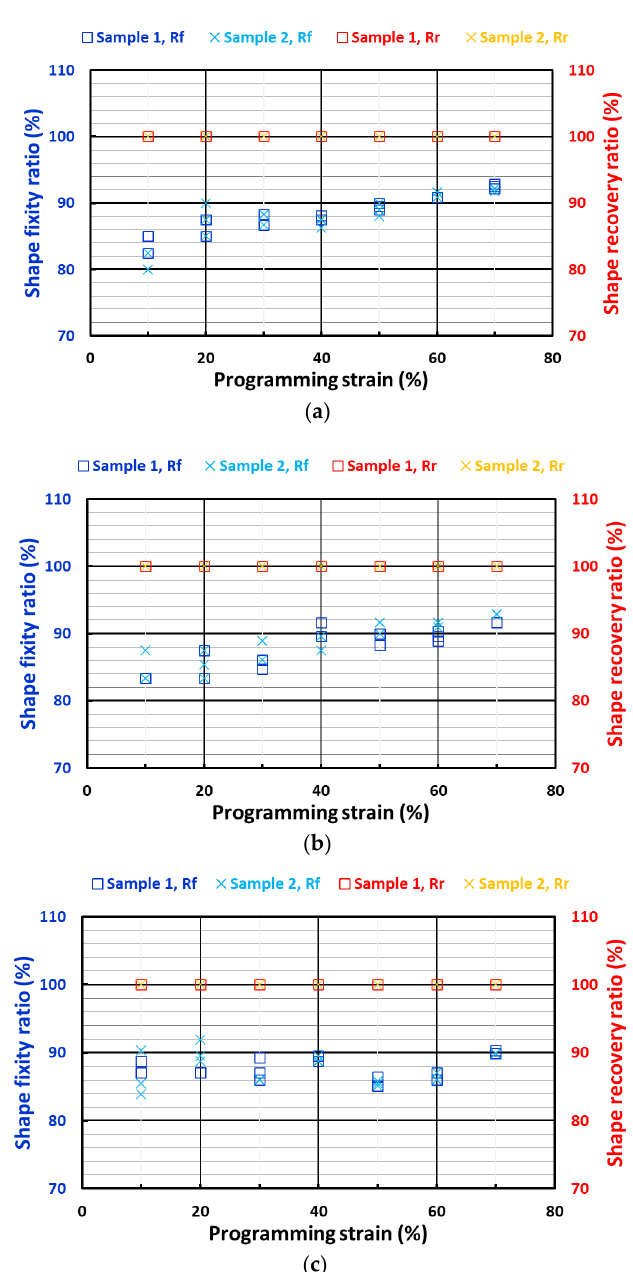
Figure 1. Shape fixity ratios and shape recovery ratios of ( a ) cylindrical samples; ( b ) cuboid samples; and ( c ) strip samples.